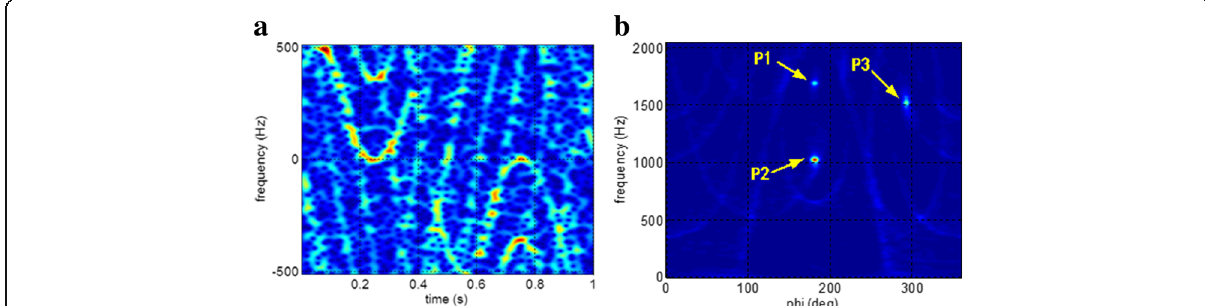
Fig. 9 Results of experiment No. 4. (carrier frequency: 340 GHz, SNR: 3 dB, scattering centers: P1, P2, and P3). a The time-frequency image. b The parameter space image